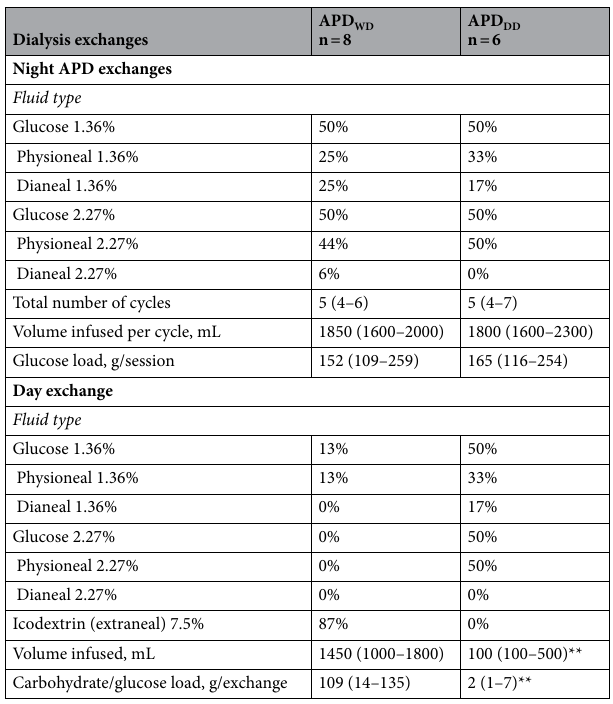
Table 2. Characteristics of automated peritoneal dialysis (APD) schemes prescribed for 8 patients on wet day (APD WD ) and for 6 patients with dry day (APD DD ) regimes and comparison of APD WD with APD DD group. Data are presented as percentage, or median (min–max). **p = 0.002; difference APD WD vs. APD